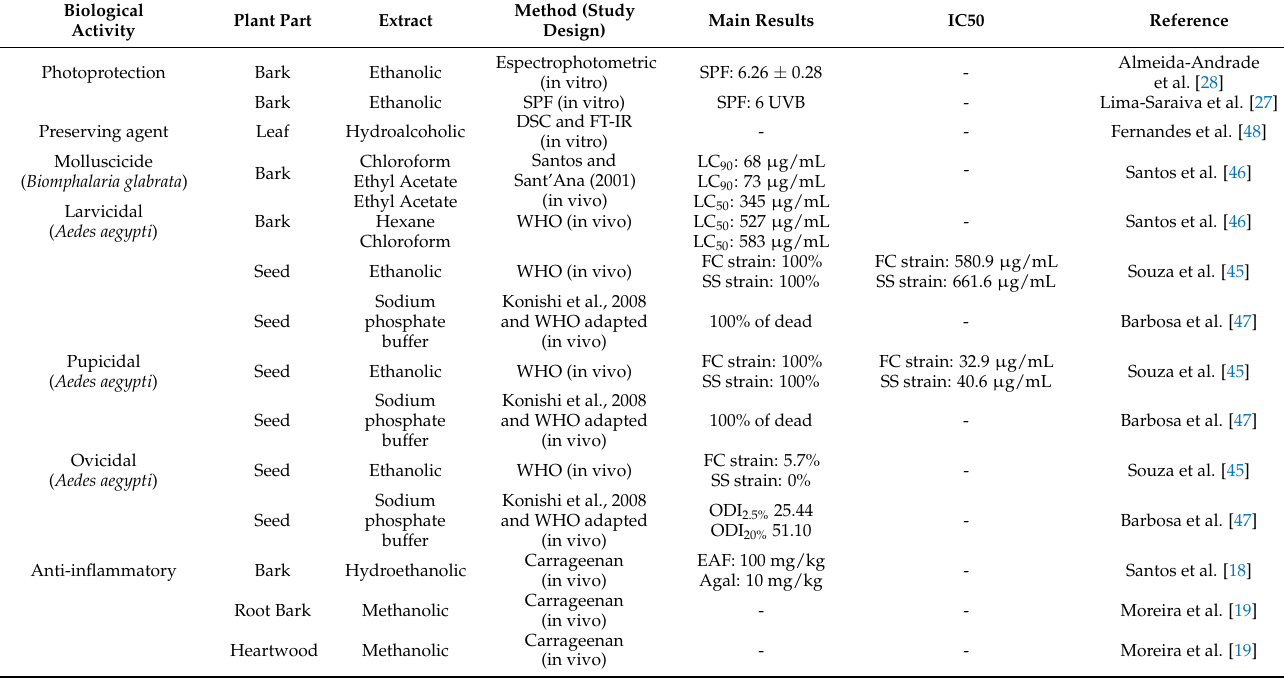
Table 7. Other biological activity from Schinopsis brasiliensis